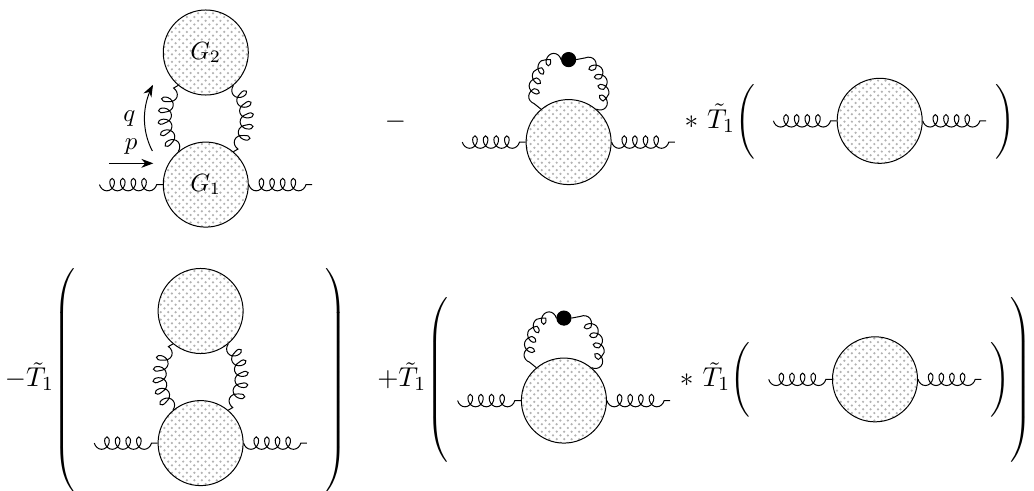
Figure 8. Soft subtraction for a gluonic self-energy nested within another gluonic self-energy. The collection of all 1PI two-point subgraphs of Γ is B (Γ) = { G